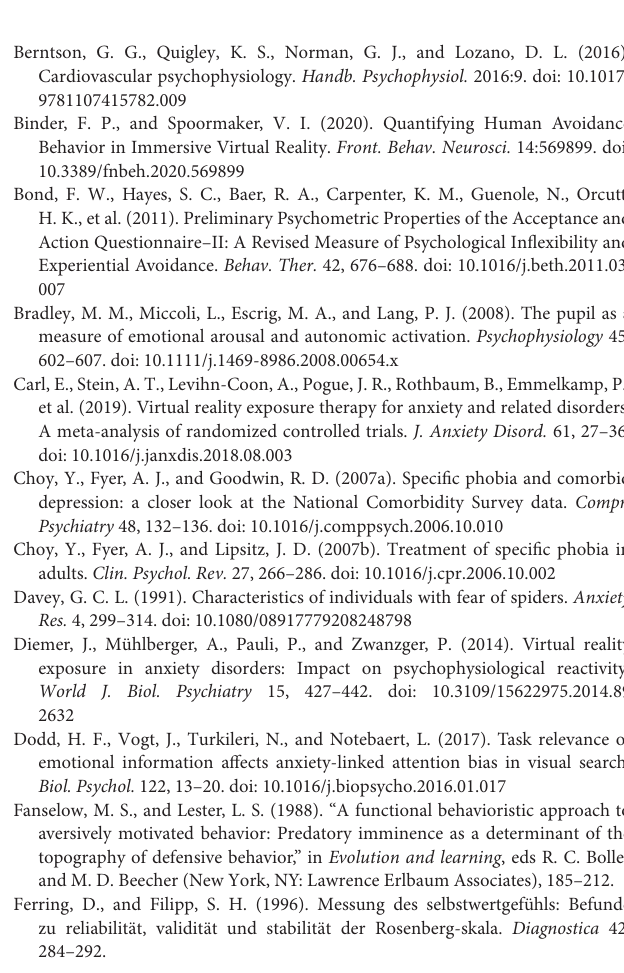
Supplementary Data Sheet 1 | Supplementary tables and figures. Supplementary Data Sheet 2 | Underlying data. Supplementary Video 1 | Video of the Fishing task. Supplementary Video 2 | Video of the Path-Choice task. Supplementary Video 3 | Video of the Touch the Enemy